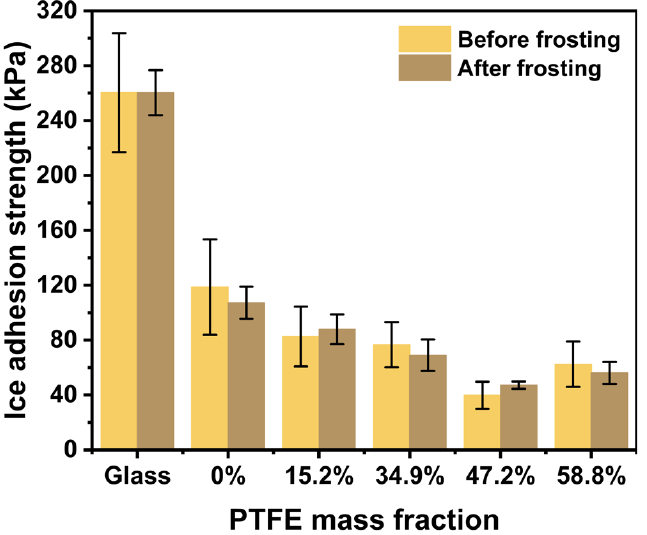
Figure 8. Ice-adhesion strength of water droplets placed on glass and coatings with different PTFE mass